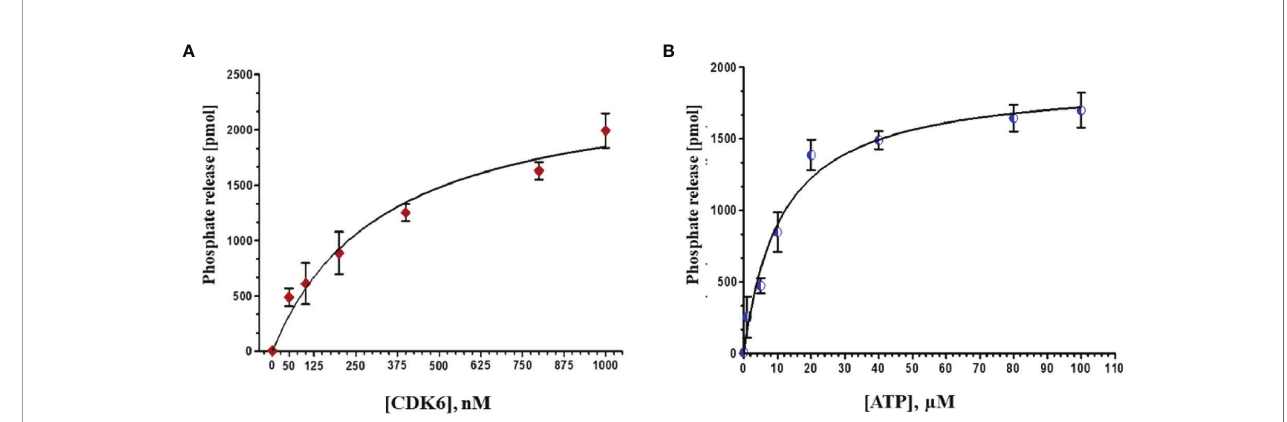
FIGURE 6 | (A) Phosphate release (pMol) with increasing concentrations of protein (0-1000 nm) at fi xed ATP concentration (20 µM). (B) With increasing concentrations of ATP (0-100 µM) at constant protein concentration (500